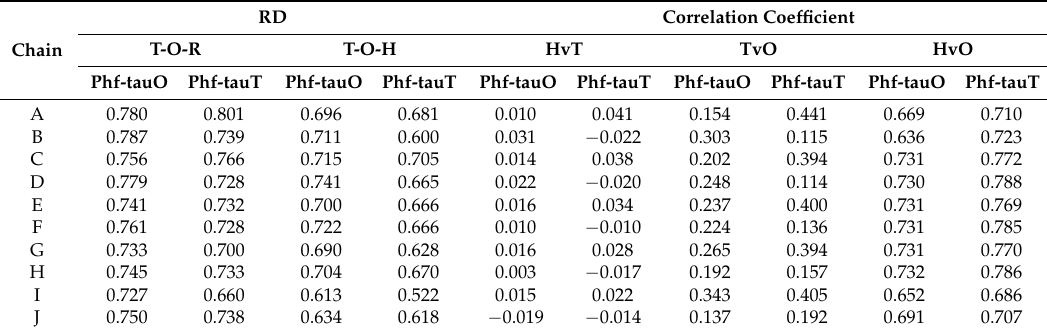
Table 2. Status of individual chains treated as components of the superfibril. The presentation of phf-tauL is omitted since due to its similarity to phf-tauO.